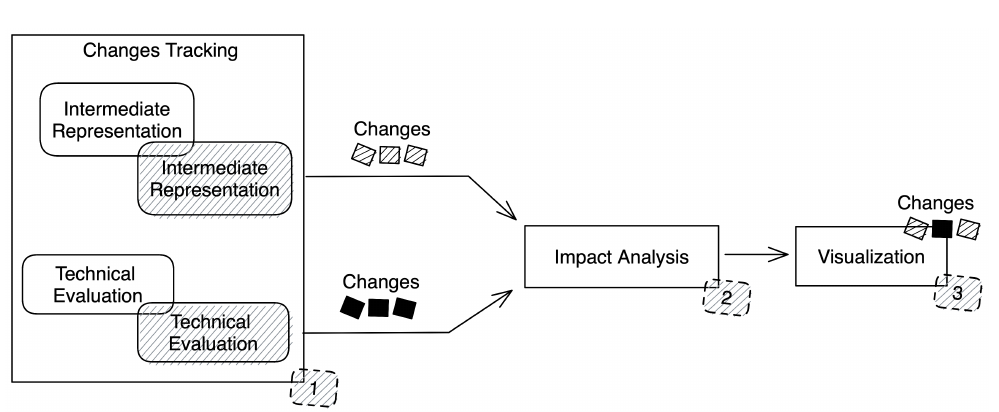
Figure 9. Evolution-designed